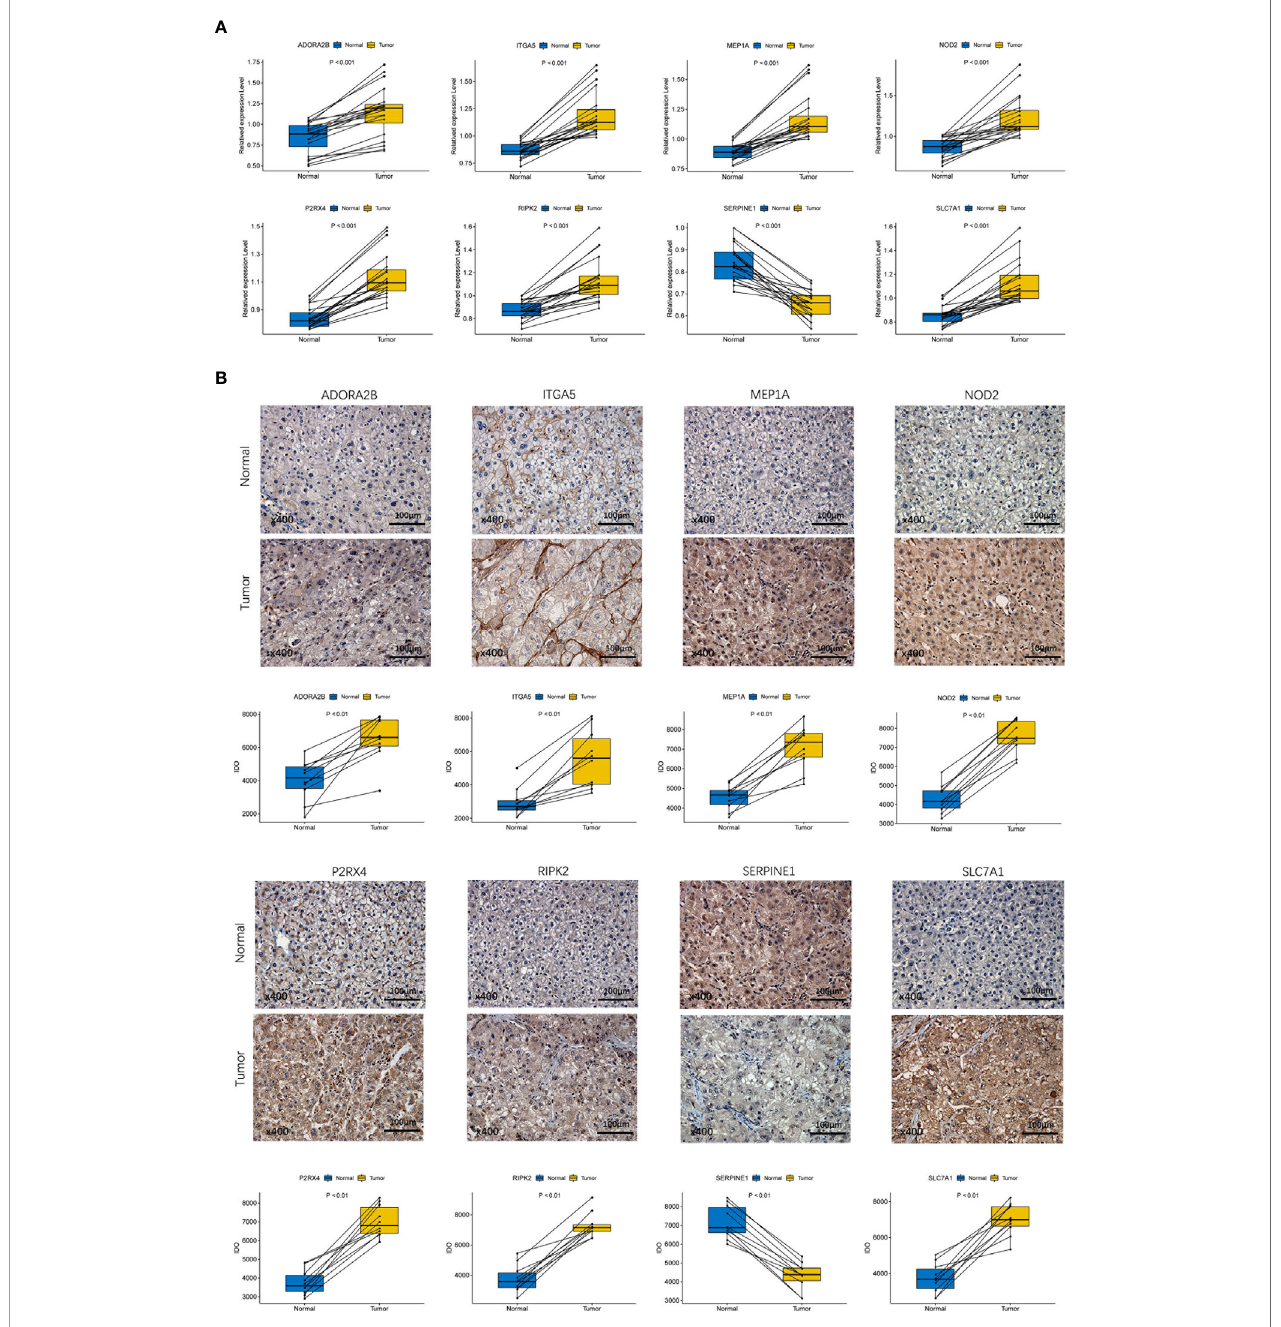
FIGURE 10 | Experiment con fi rmed the difference of the prognostic gene expression between HCC and adjacent non-tumor tissues. (A) The mRNA expression analysis by qRT-RCR. (B) The protein expression analysis by